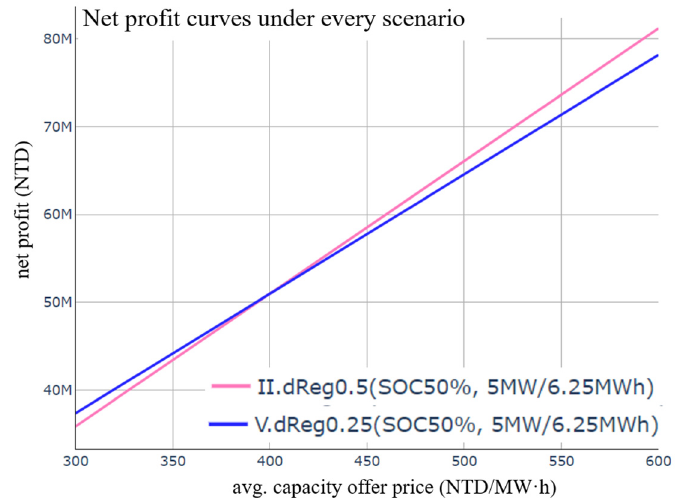
Figure 24. Net profit under dReg0.5 and dReg0.25.